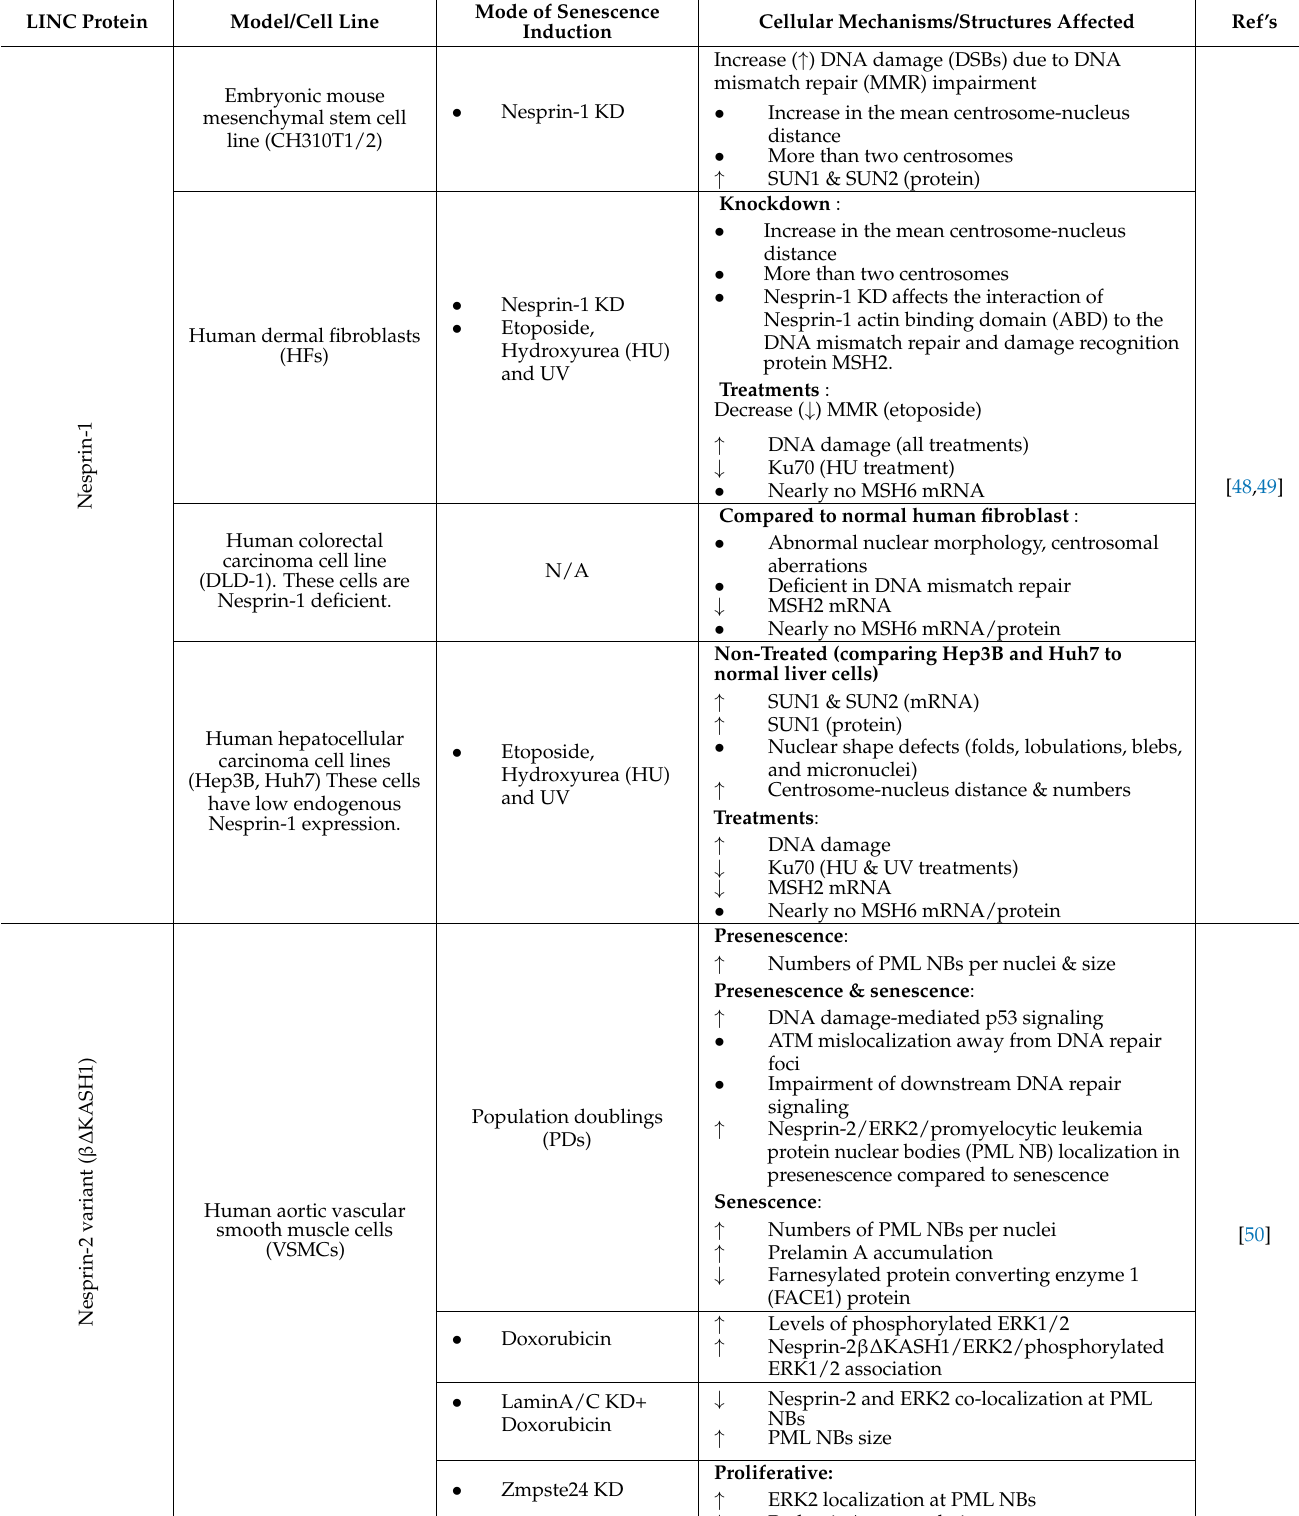
Table 1. Summary of LINC complex proteins in